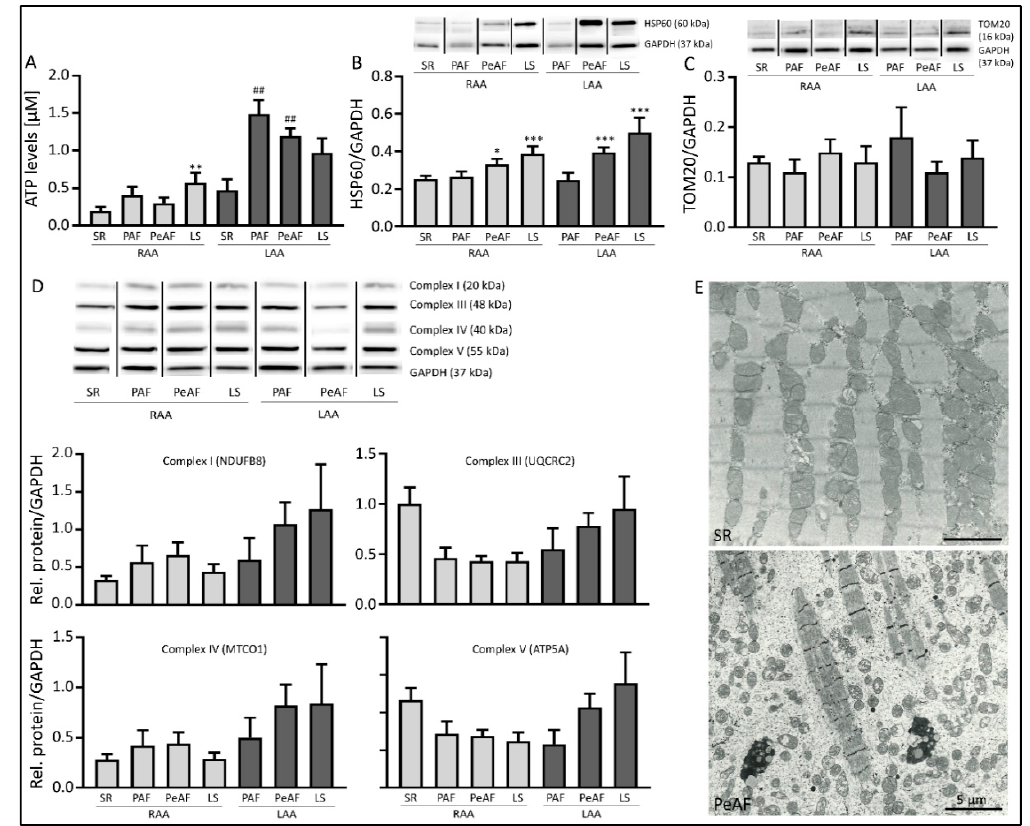
Figure 2. AF patients show mitochondrial dysfunction. ( A ) Cellular ATP levels in right atrial appendage (RAA) or left atrial appendage (LAA) of patients in sinus rhythm (SR), paroxysmal (PAF), persistent (PeAF) or longstanding persistent (LS) AF. ( B ) Top panel represent Western blot of HSP60 and GAPDH, lower panel reveals quantified data of HSP60 normalized for GAPDH. ( C ) Top panel represent Western blot of TOM20 and GAPDH, lower panel reveals quantified data of TOM20 normalized for GAPDH. ( D ) Top panel represent Western blot of respiratory chain complexes I, III, IV and V. Lower panels reveal quantified data of the respiratory chain complexes normalized for GAPDH in RAA of SR and RAA and LAA of PAF, PeAF and LS patients. ( E ) Electron microscopic images of LAA of a patient in SR (top), showing normal sarcomere structure and mitochondrial localization along the sarcomeres, and LAA of PeAF, showing myolysis and dispersed mitochondria. * p < 0.05, ** p < 0.01, *** p < 0.001 vs. SR RAA, ## p < 0.01 vs. SR LAA.